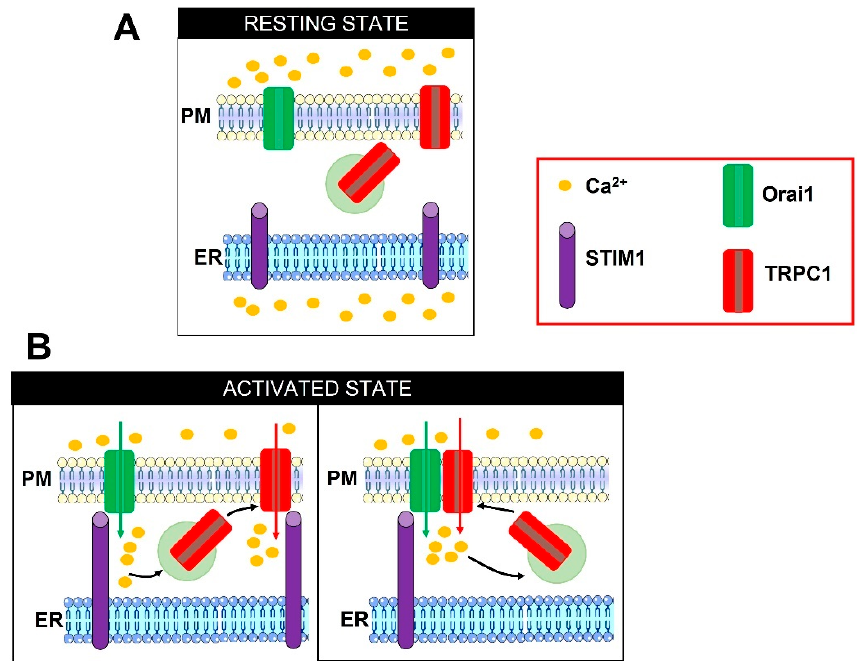
Figure 1. Proposed models for I CRAC , I SOC , and I CRAC − like currents. In the absence of extracellular stimulation, STIM1 is homogeneously distributed within ER cisternae, whereas Orai1, TRPC1, and TRPC4 are located on the PM. Upon depletion of the ER Ca 2+ store, STIM1 aggregates and translocates in close apposition to the PM, thereby recruiting Orai1 hexamers into spatially confined puncta and activating the I CRAC . Orai1 − mediated extracellular Ca 2+ entry can cause TRPC1 insertion into the plasma membrane (shown in Figure 2), thereby enabling TRPC1 activation by STIM1 and activating the I SOC . Finally, STIM1 can determine the assembly of a complex ion channel signalplex consisting also of Orai1, TRPC1, and TRPC4 and responsible for the development of I CRAC − like currents. As explained in Section 6.1, this supermolecular channel complex includes 1 TRPC1 subunit and 2 TRPC4 subunits. The lower current density of the I CRAC as compared to the I SOC and the I CRAC -like current reflects the single-channel conductance of Orai1 channels, which is 1000-fold lower as compared to TRPC channels. The current density is defined by the ratio between the magnitude of an ion current, in pA, and the cell membrane capacitance, in pF.